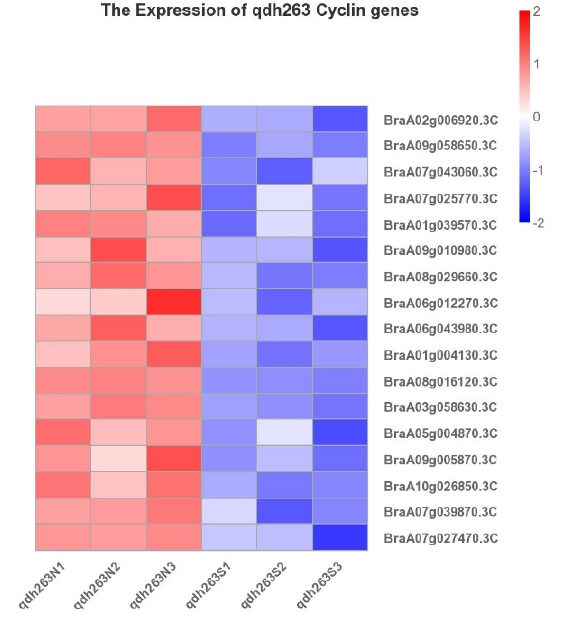
Figure 9. Transcriptomic expression analysis of the Brcyclin genes in the Chinese cabbage-cabbage